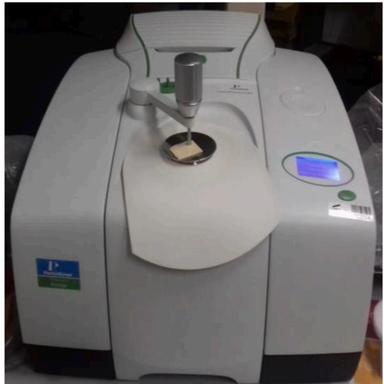
FTIR spectrometer.